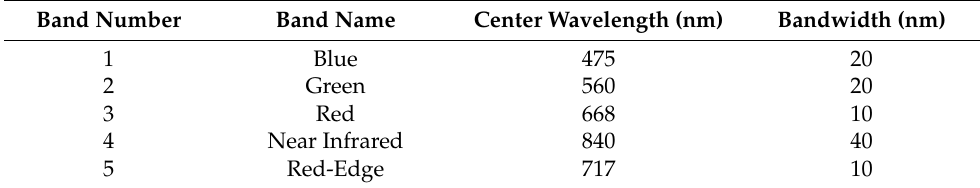
Table 1. Wavebands captured by the multispectral sensor equipped on an unmanned aerial vehicle. Band Number Band Name Center Wavelength (nm) Bandwidth (nm) 1 Blue